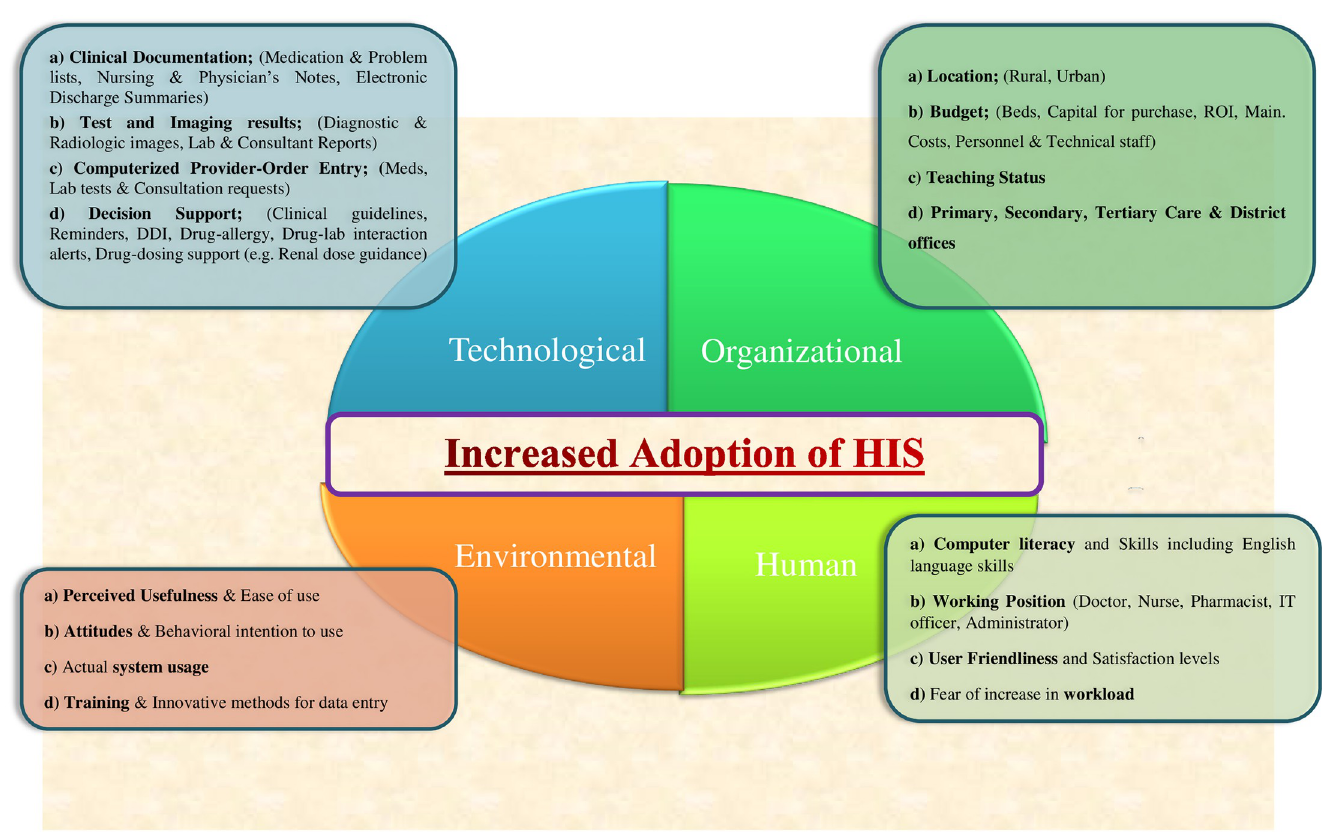
Fig 1. Conceptual framework of the study. A conceptual framework illustrating the relationship between technological, environmental, organizational and human factors regarding the successful adoption of health information systems.